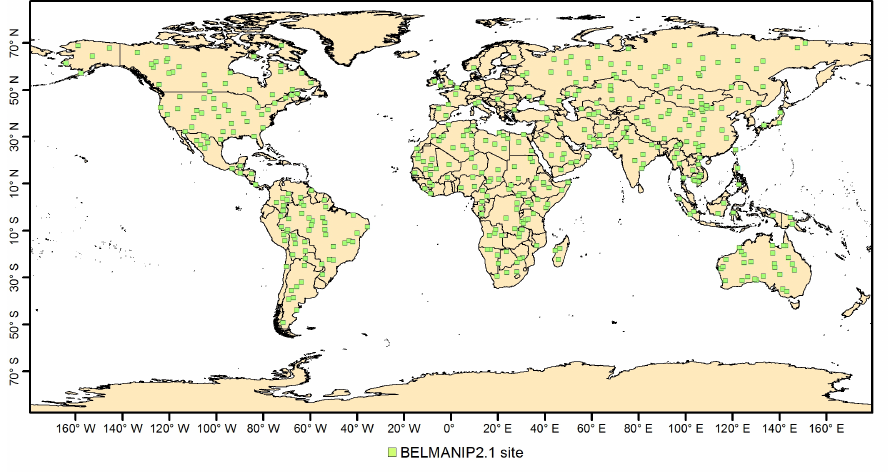
Figure 6. Sites location of the BELMANIP-2.1 network used for intercomparison of LAI and FAPAR retrievals and MOD15A3H LAI/FAPAR